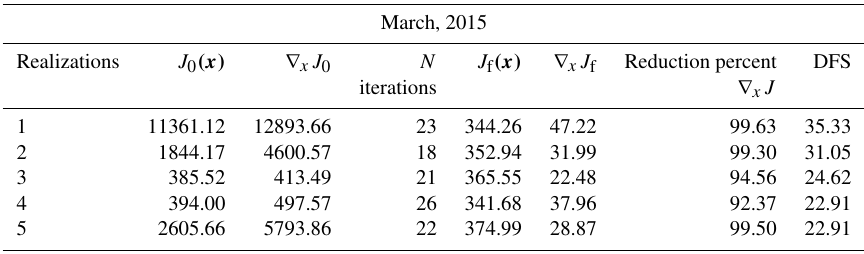
∇ x J ∇ x J f and f are for the end of the